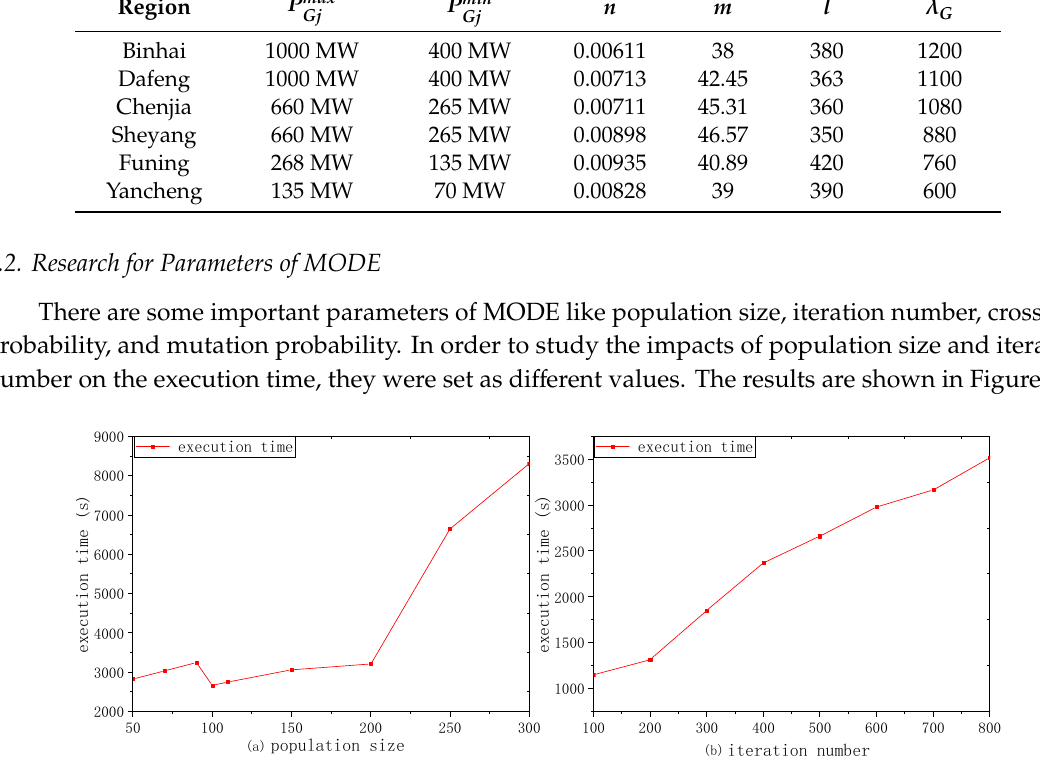
Table 4. Run time and hypervolume under different population sizes.